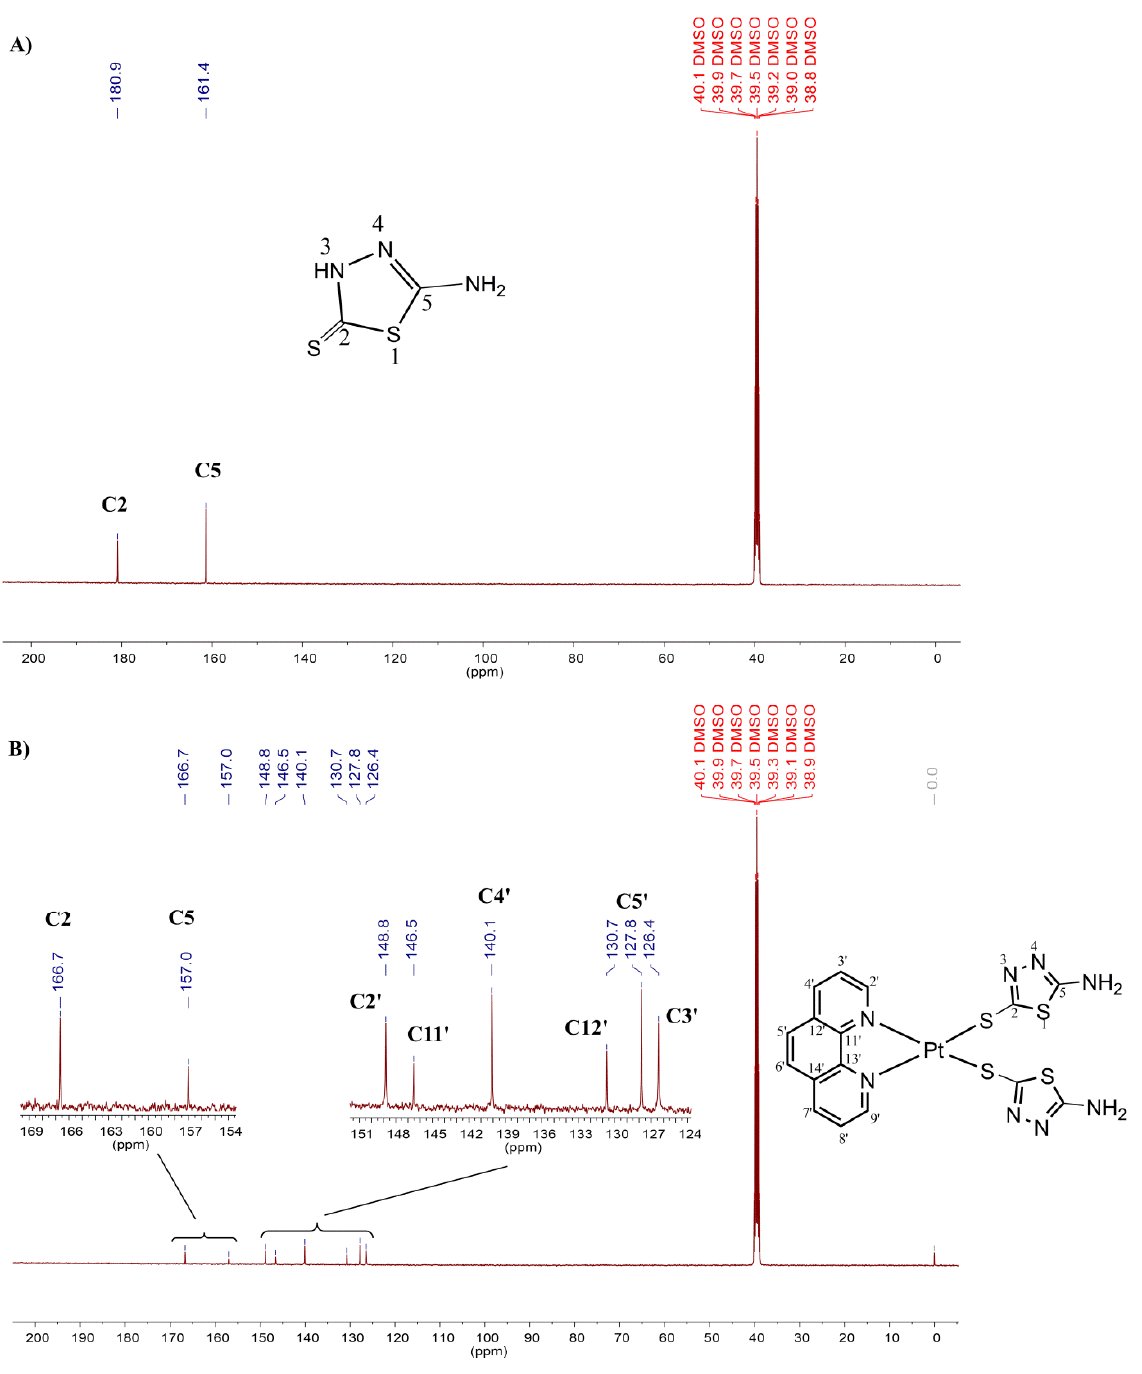
Figure 2. 1 H NMR spectrum (DMSO- d 6 , 400 MHz) of the ligand 5-amino-1,3,4-thiadiazole-2(3H)- thione with expansion from 12–14 ppm ( A ) and of the complex I expanded from 7.5–10.5 ppm (region assigned to hydrogens of the phenanthroline) ( B ).